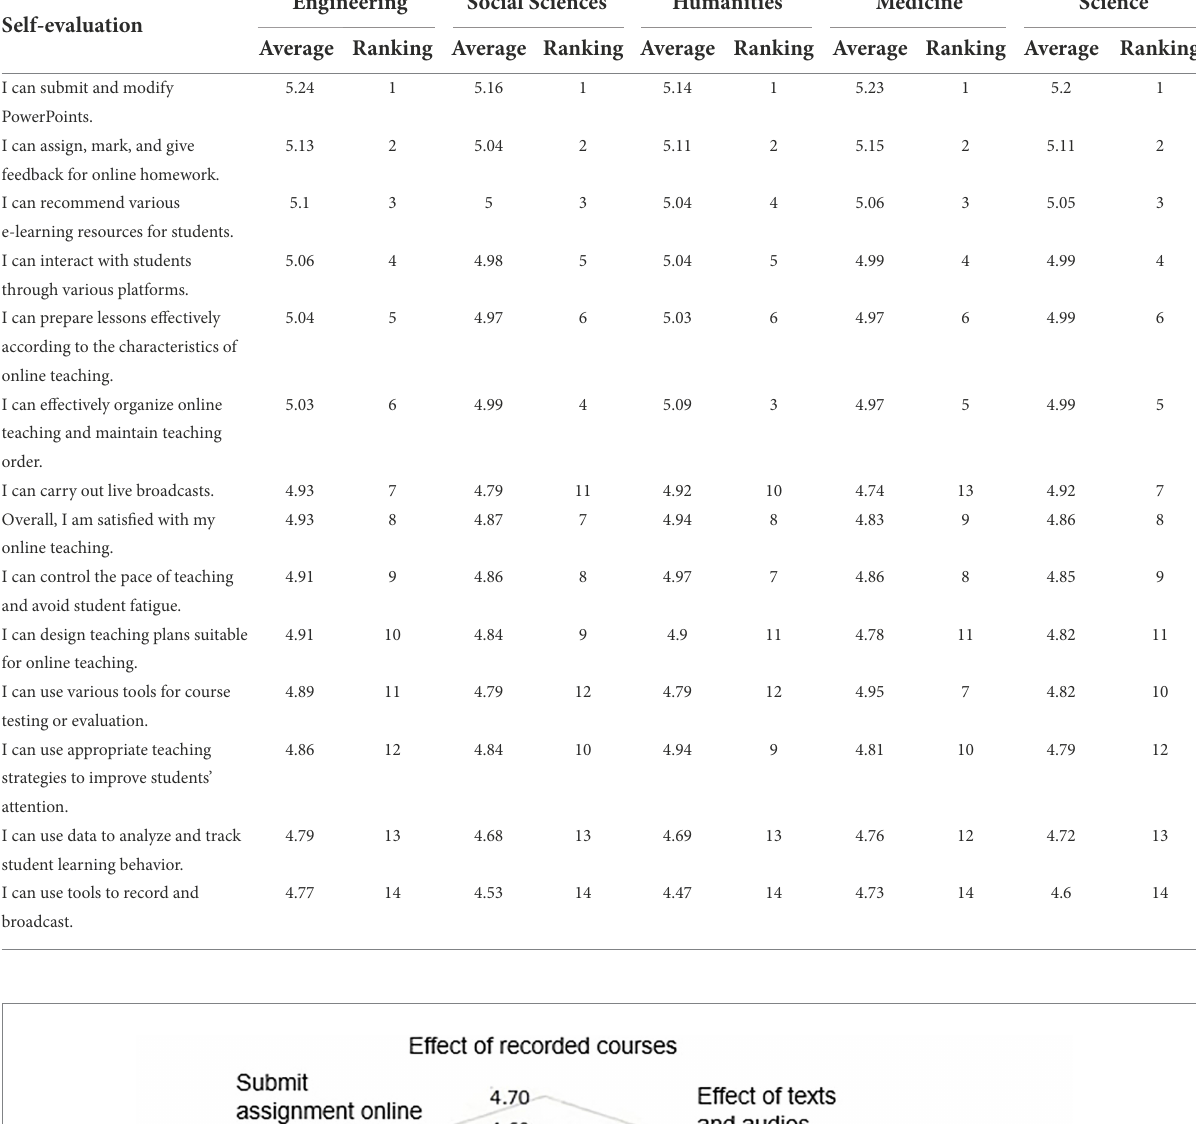
TABLE 3 Teachers’ online education ability of different disciplines. Engineering Social Sciences Self-evaluation